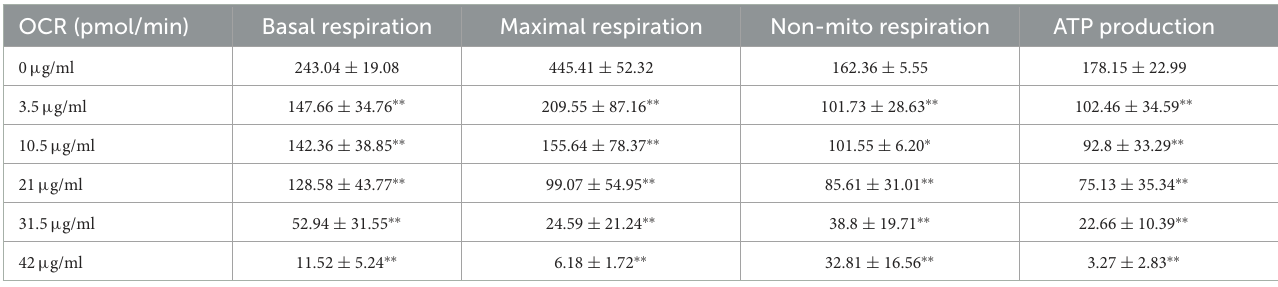
TABLE 1 Parameters of mitochondrial oxidative